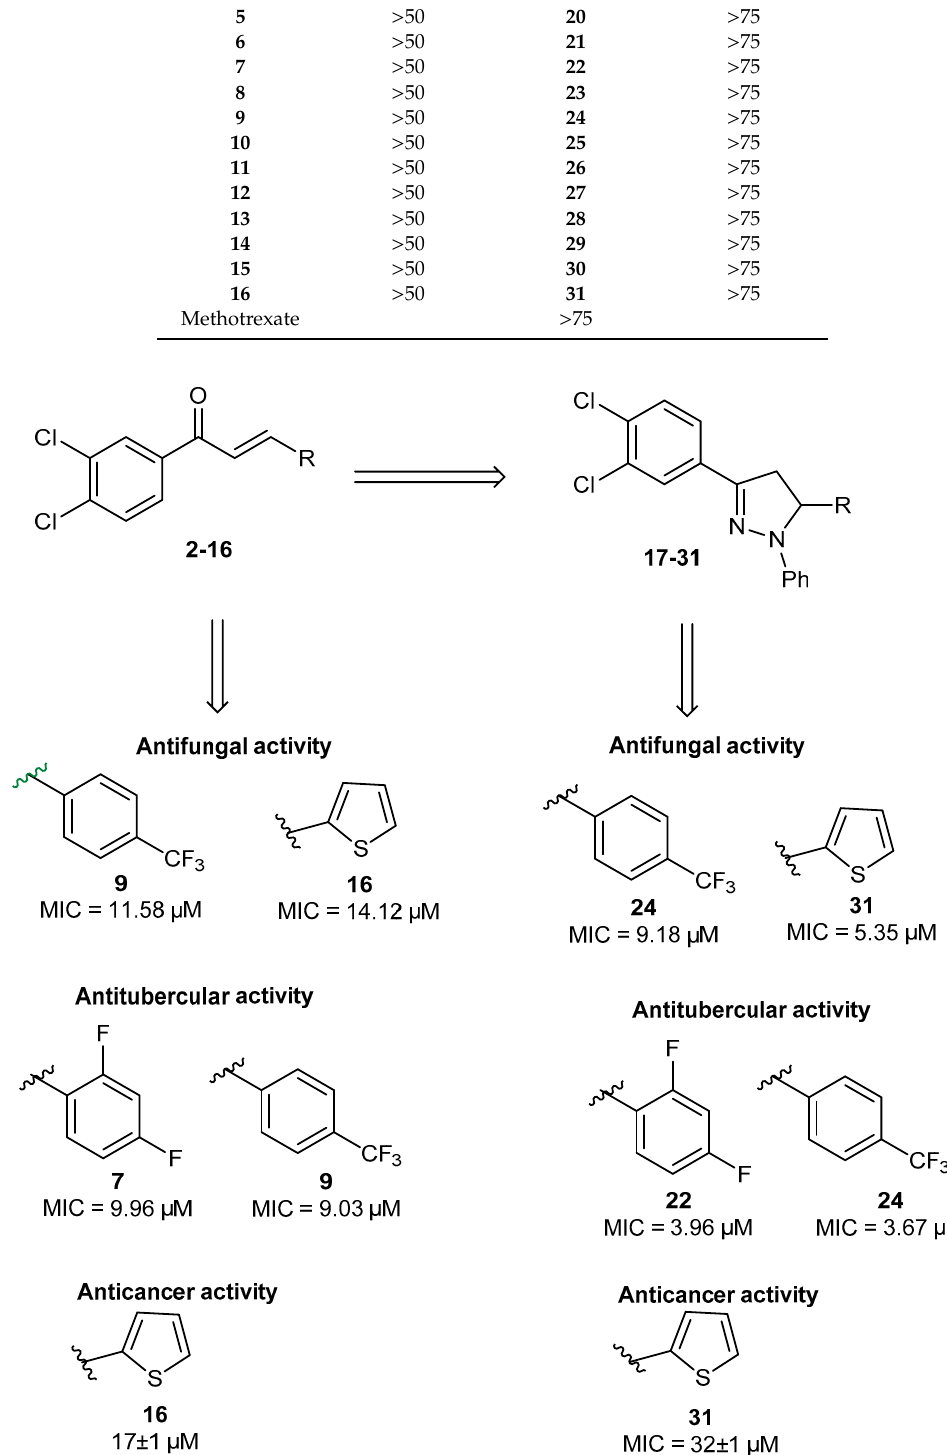
Figure 4. Summary of the antifungal, antitubercular, and antiproliferative activities of chalcones ( 2 – 16 ) and dihydropyrazoles ( 17 – 31 ).